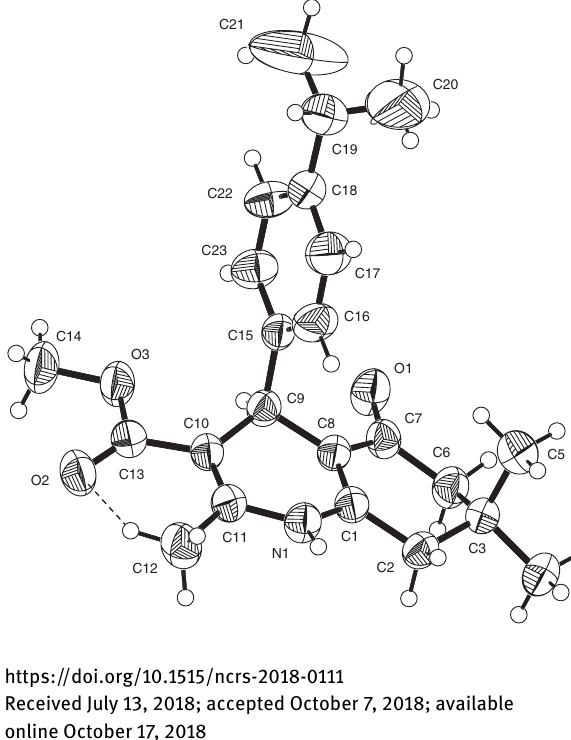
Table 1: Data collection and handling.